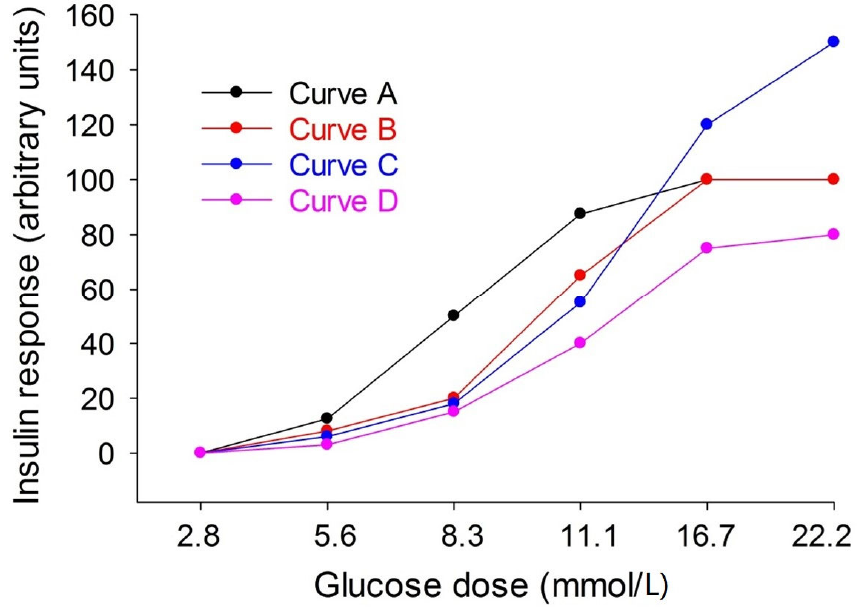
Figure 5. Four different patterns of relation between glucose dose and insulin secretion. For explanation see discussion section.